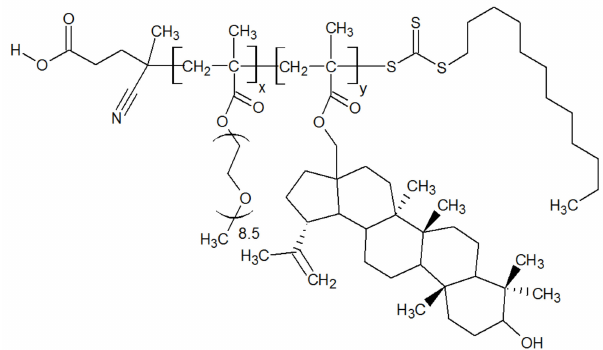
Figure 1. General structural formula of synthesized copolymers of methoxyoligo(ethylene gly- col)methacrylate and betulin methacrylate.